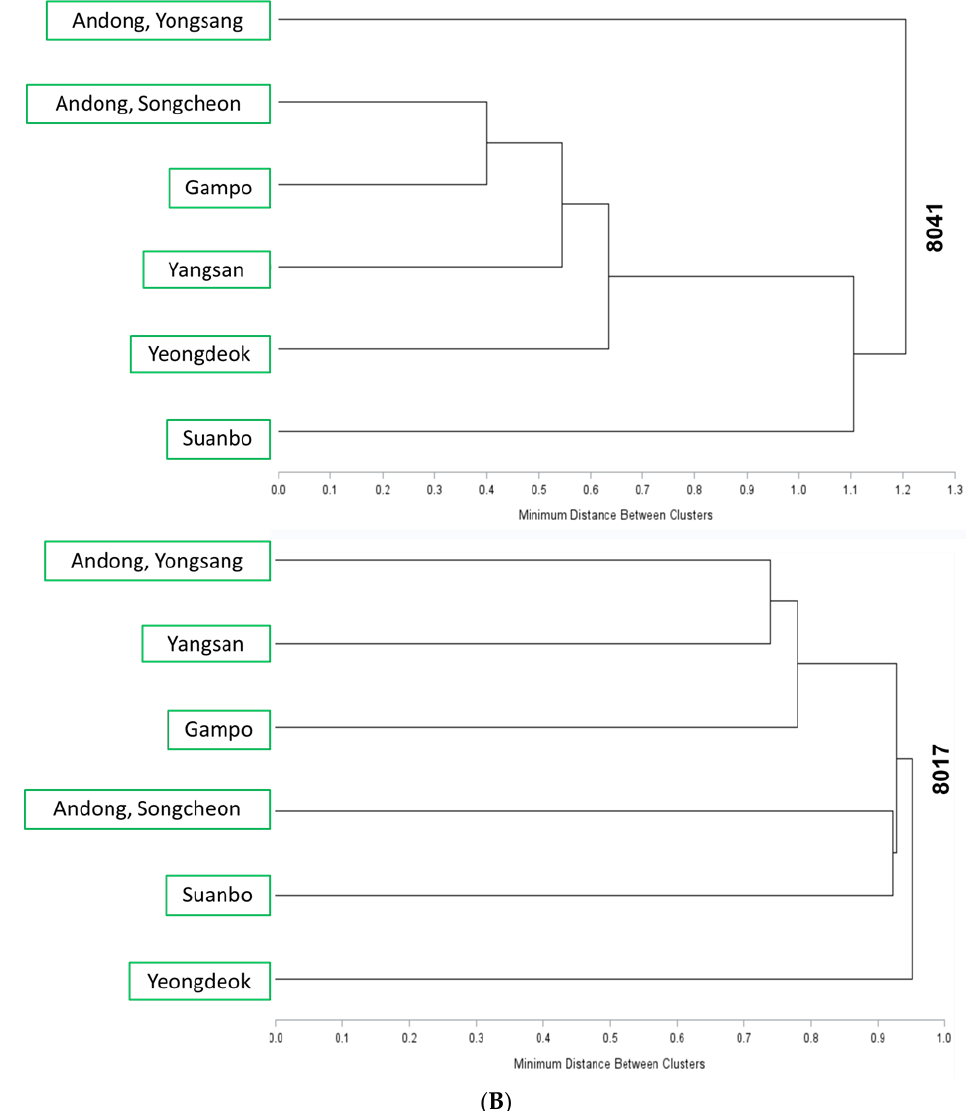
Figure 3. Genetic distance among local populations of T . tabaci infesting Welsh onion using RAPD. ( A ) A map indicating sampling sites (indicated by arrows) of T . tabaci in Korea. ( B ) Clustering analysis of RAPD polymorphic markers (8017 and 8041) using PROC CLUSTER [19].